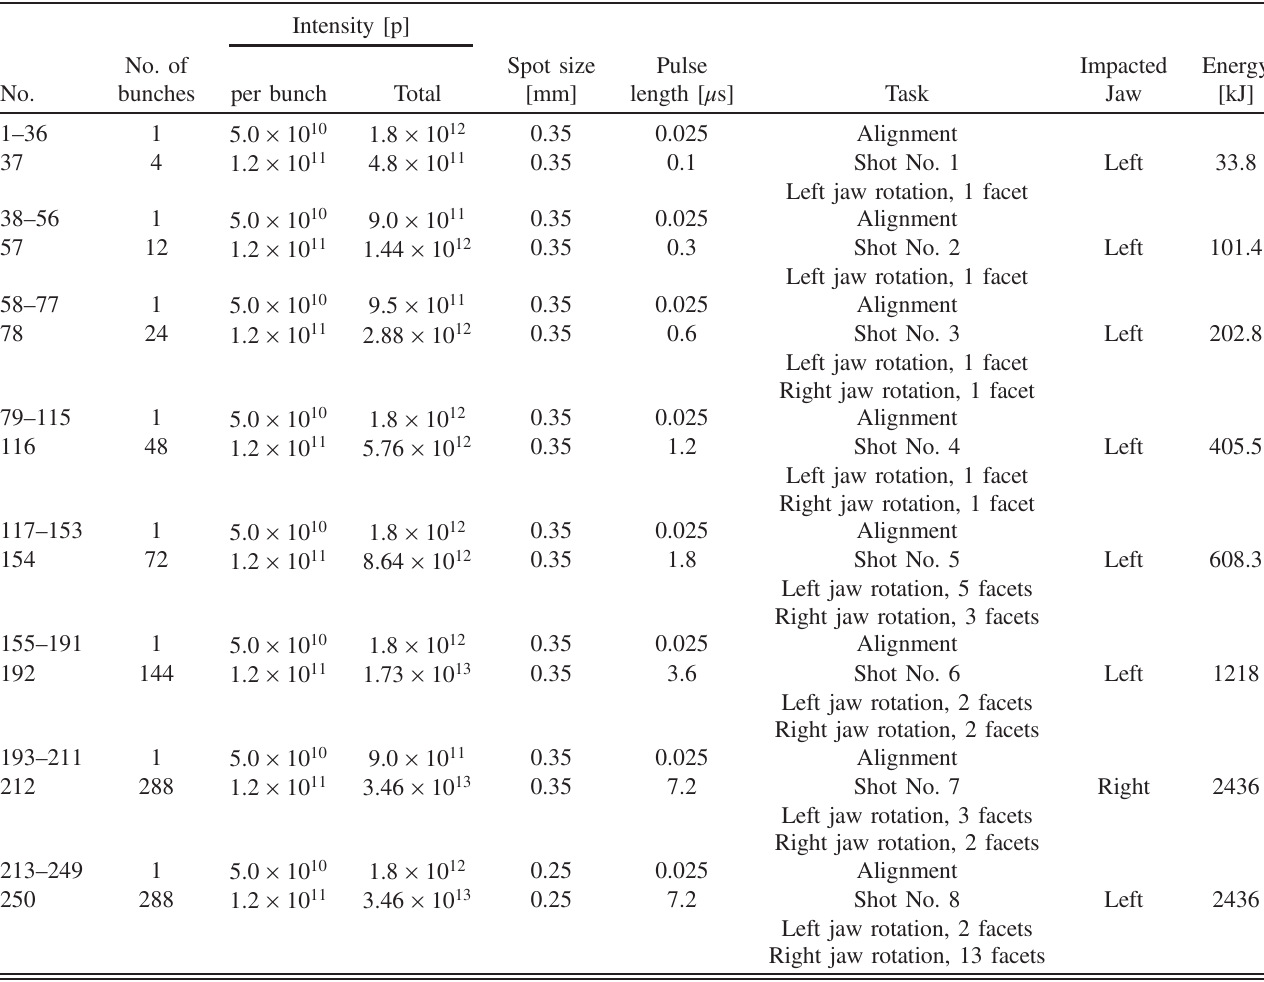
TABLE III. Pulse list used in the HRMT-21 beam test, showing the impacted jaw and the number of facets rotated in each